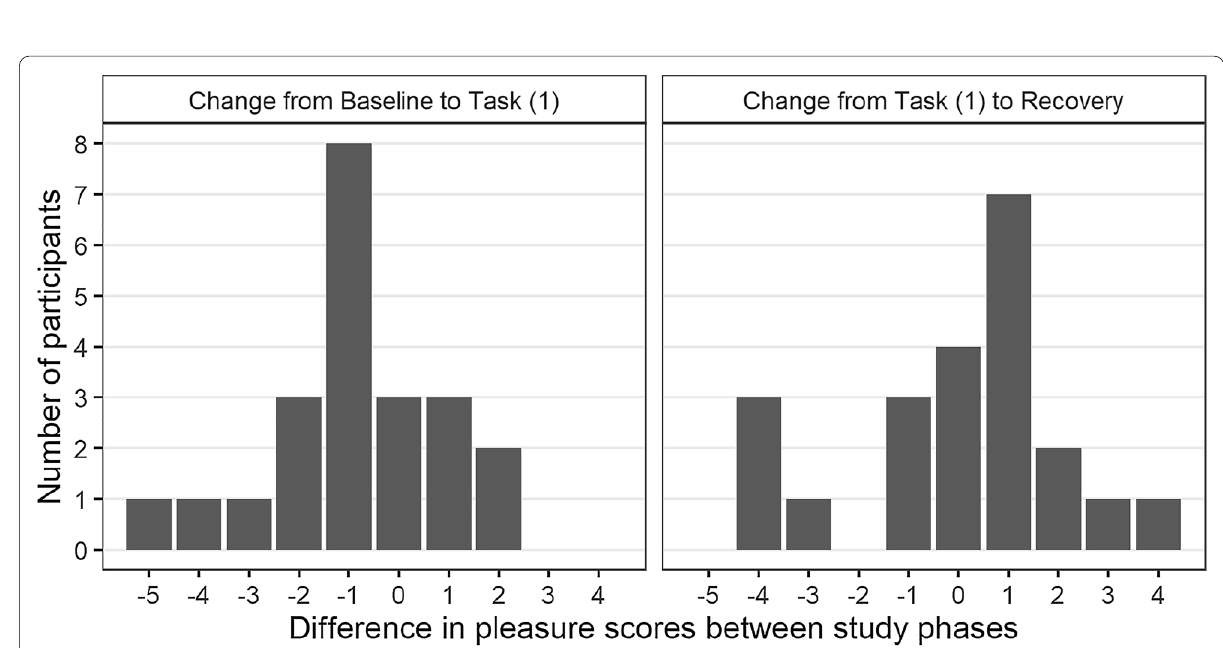
Fig. 4 Changes in pleasure scores within each participant from Baseline to Task (1) (left) and from Task (1) to Recovery